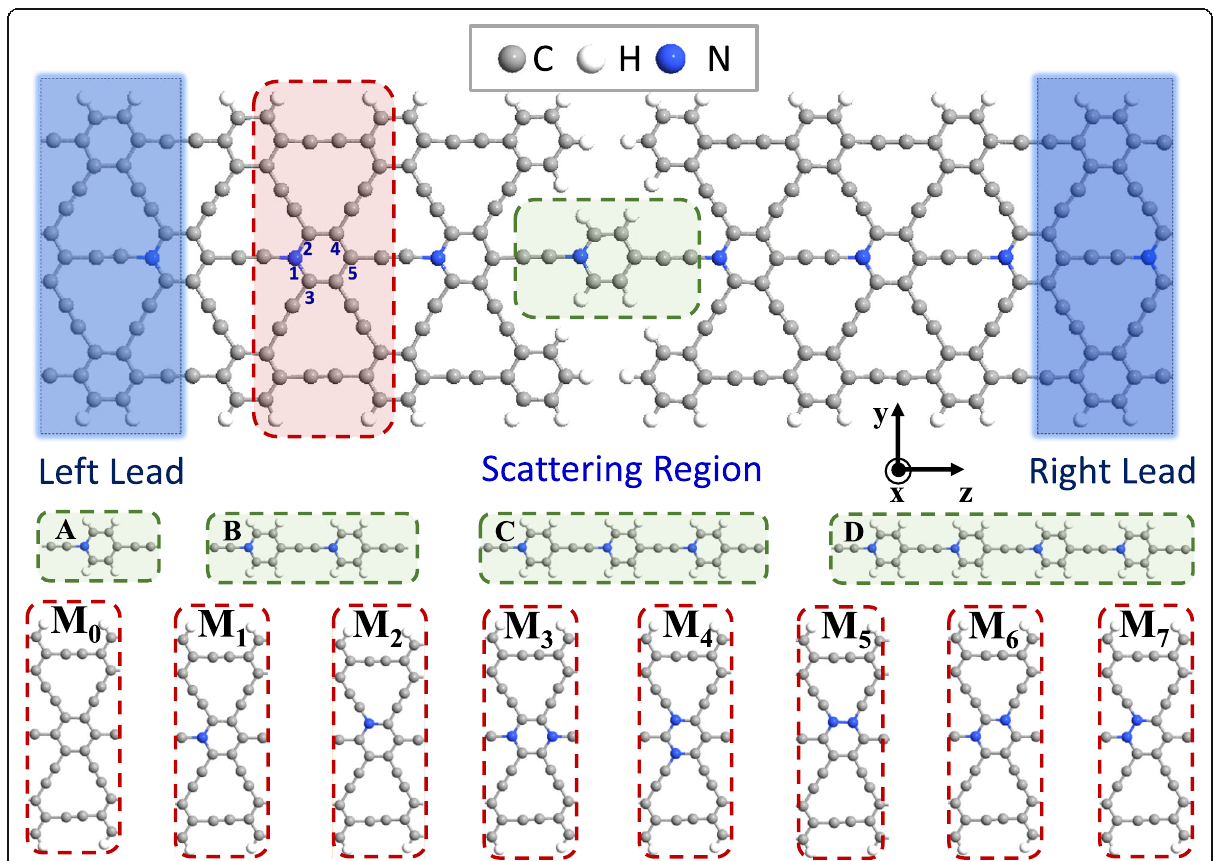
Fig. 1 (Color online) Schematic views of the two-probe systems. For clarity, the device with single N-doping (the second super cell at the bottom panel as M 1 ) of A γ GYNR is chosen as the main diagram in the top panel. The blue shaded rectangular regions indicate the left and right leads, between which is the central scattering region. The gray, white, and blue solid spheres represent the carbon, hydrogen, and nitrogen atoms, respectively. The transport direction is along the z axis. Further, the green shaded molecular unit at the main diagram can be periodically replicated leading to produce the four structures with different lengths of molecular chains including benzene and acetenyl molecules in the middle panel, which have been named as A – D. In addition, the red shaded frame denotes the periodic super unit cell of the nanoribbon which can be changed by the ones of M 0 – M 7 without or with single/double N-substituting positions in the bottom panel. For convenience, the atomic positions of C 6 ring are numbered as 1, 2, 3, 4, and 5 as pointed under the corresponding atoms of the red frame,